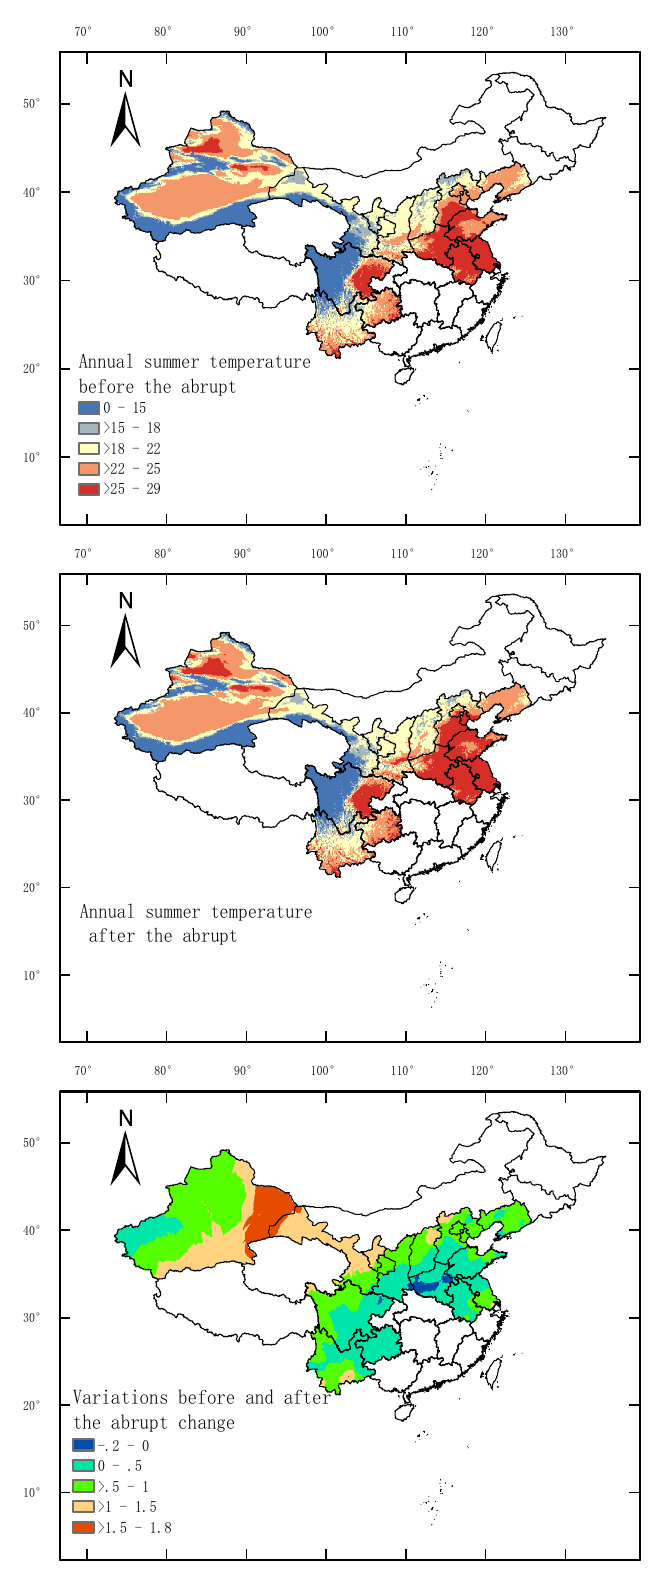
Figure 6. The changes in spatial distribution of the major apple-producing regions in China before and after the abrupt change of average summer temperature, wherein the yellow area represents the optimal range of average summer temperature for high-quality apple growing.